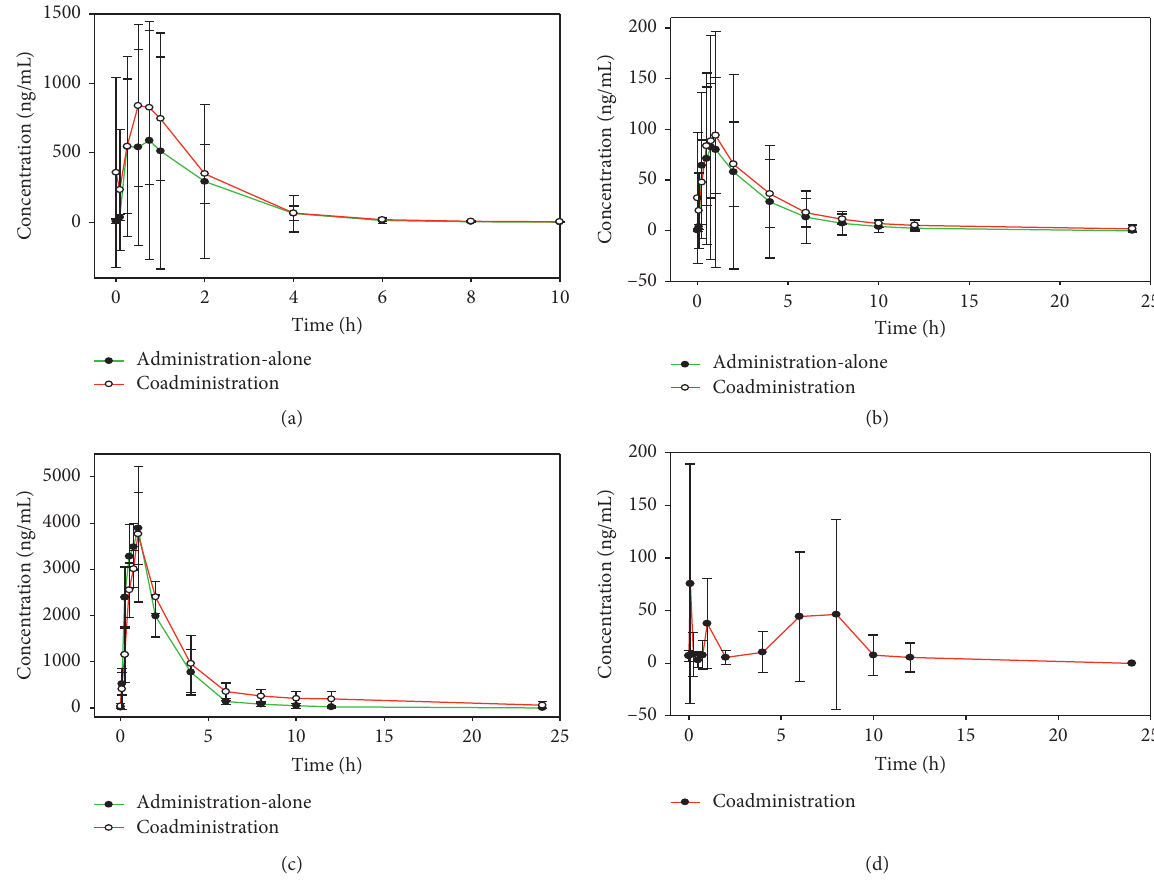
Figure 1: Comparison of plasma concentration-time curves of each compound by administration-alone and coadministration (a) for ISO, (b) for RHY, (c) for GAS, and (d) for Table 1: Pharmacokinetic parameters of the determining compounds.